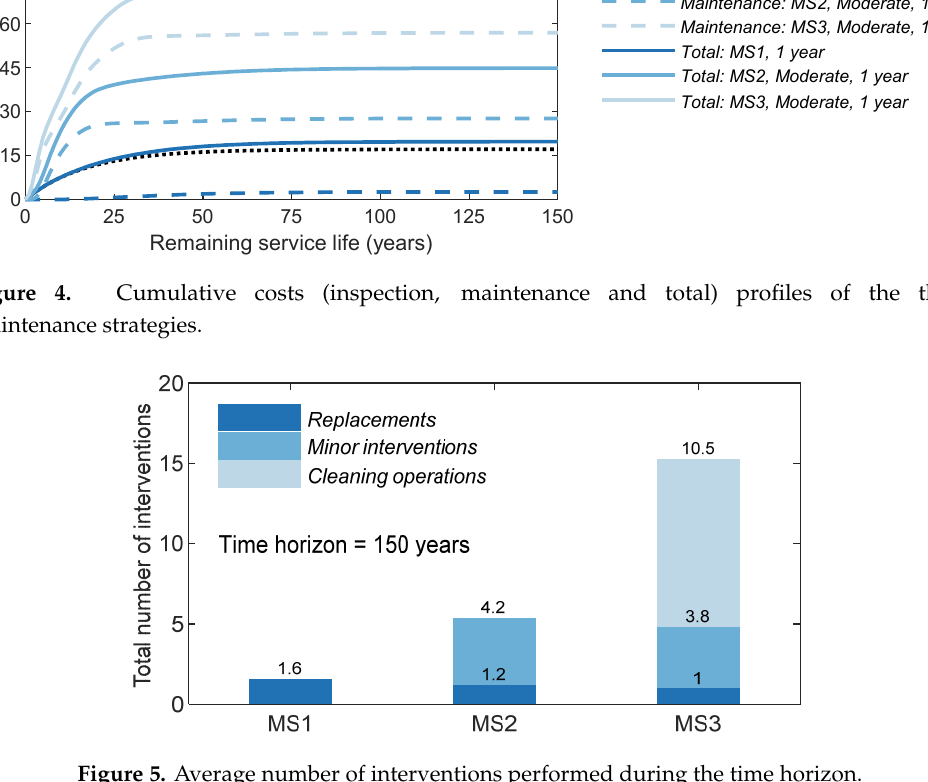
Figure 5. Average number of interventions performed during the time horizon.